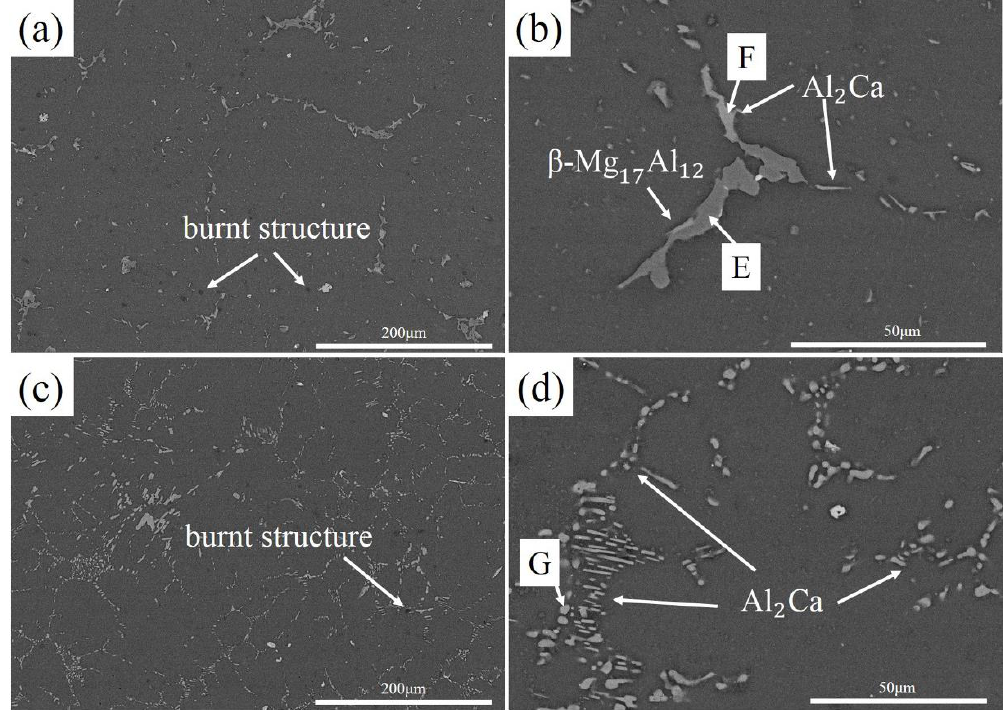
Figure 5. Microstructures of ( a ), ( b ) AZX801 and ( c ), ( d ) AZX802 alloys after multi-stage oxidation in air. The chain-shaped phase, new lamellar eutectic and network structure which are considered as β- Mg 17 Al 12 + Al 2 Ca eutectic micro-constituent are fragmented after oxidation. Table 2. EDS results taken from different positions as denoted in Figures 8 and 10. Zone Mg